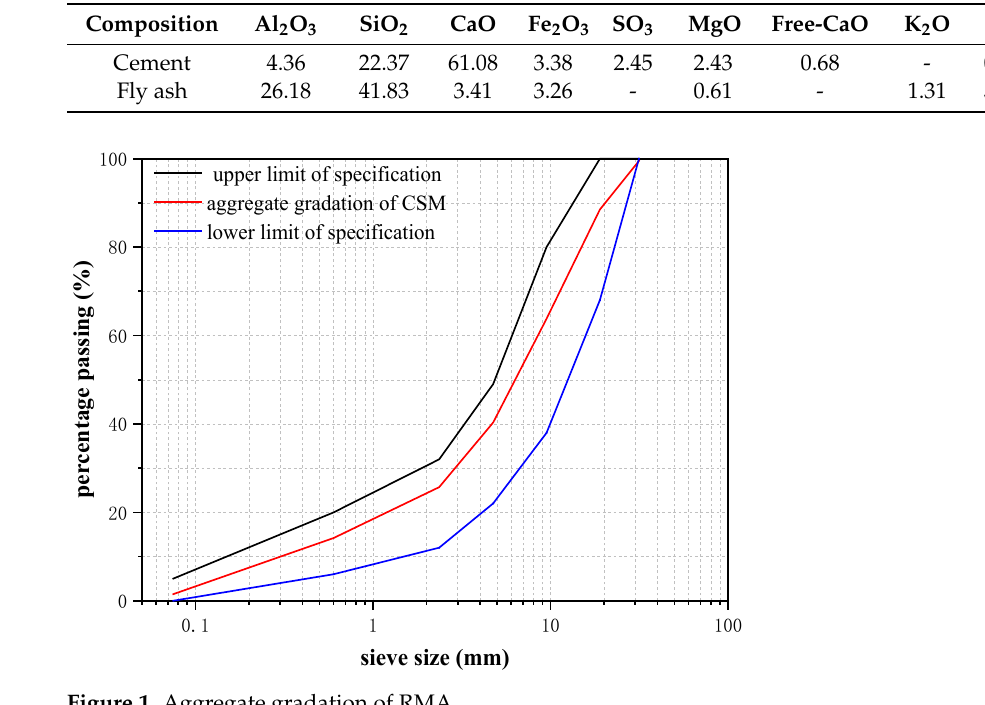
Figure 1. Aggregate gradation of RMA.